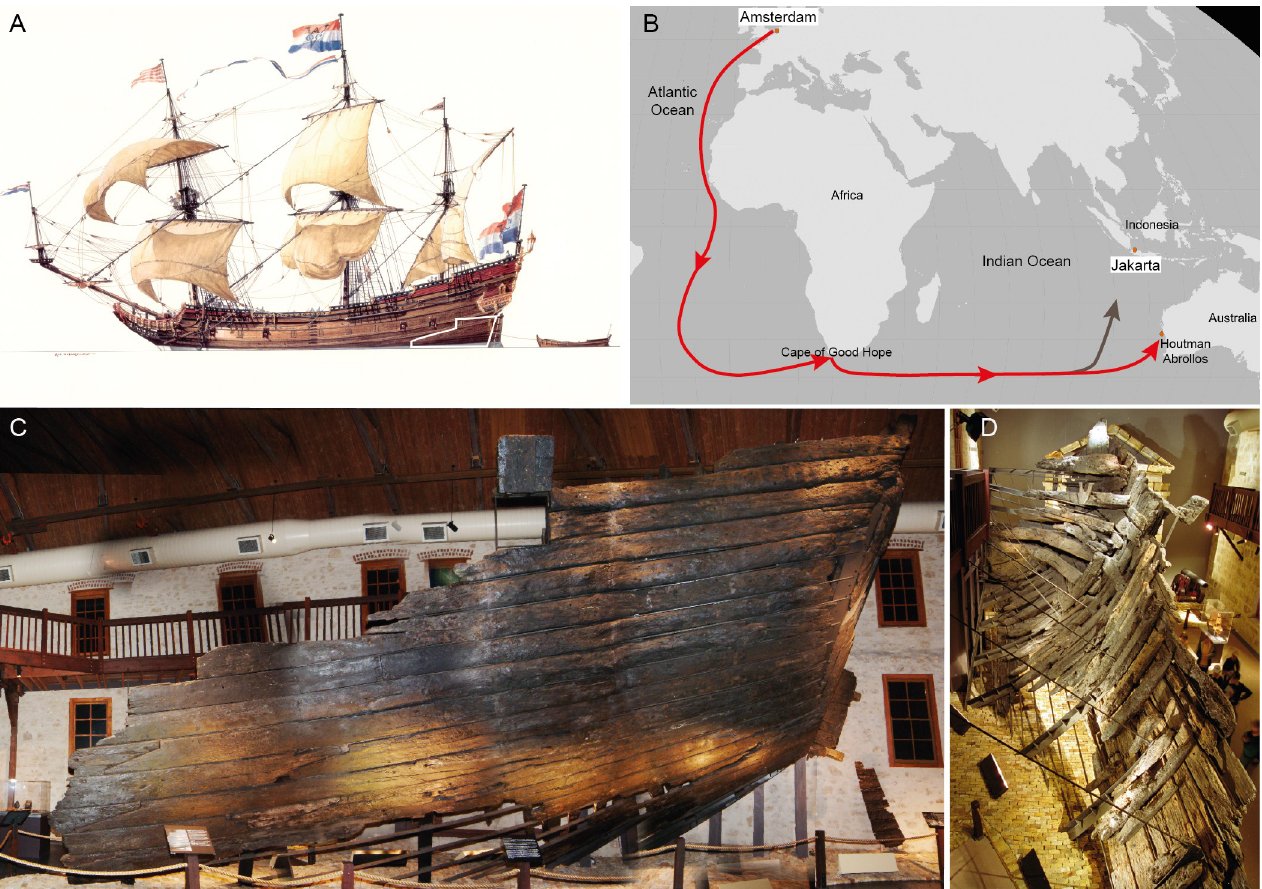
Fig 1. Batavia ship and shipwreck. A) Ship illustrated by Ross Shardlow, with a white line indicating the preserved section of the port-side and transom raised from the shipwreck site; B) route sailed from the Netherlands to the wreckage site on Morning Reef off Beacon Island (Houtman Abrolhos Archipelago); C,D) ship’s hull on display at the Western Australian Shipwrecks Museum in Fremantle (Photos: P.E. Baker, Western Australian Museum).